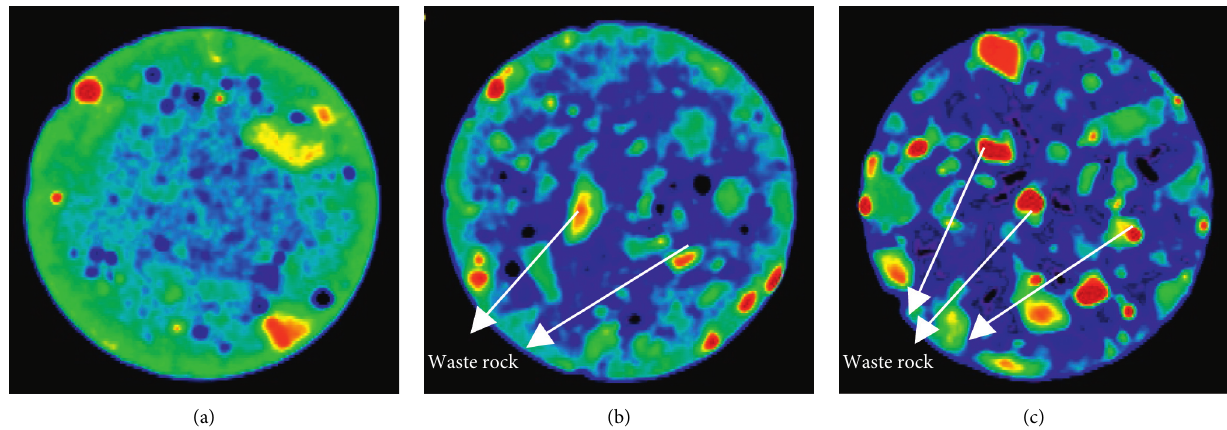
Figure 1: X-ray CTscan images of the backfill body with different mixture ratios [18], (a) waste rock content of 10%, (b) waste rock content of 30%, and (c) waste rock content of 50%.